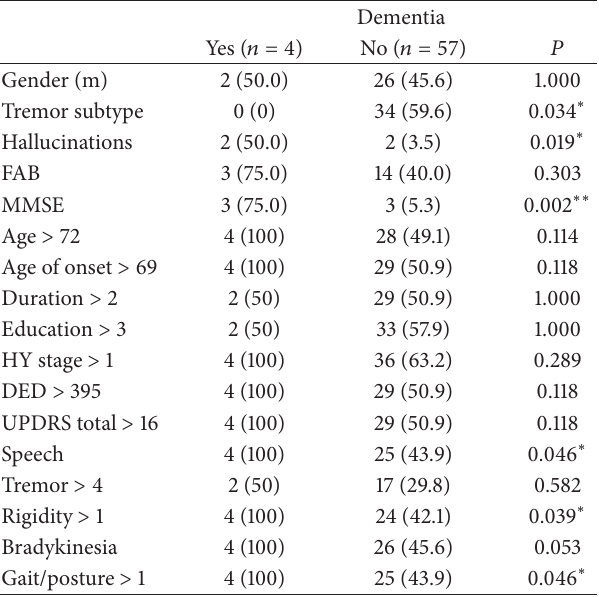
Table 4: Baseline comparisons between the PD patients with and without